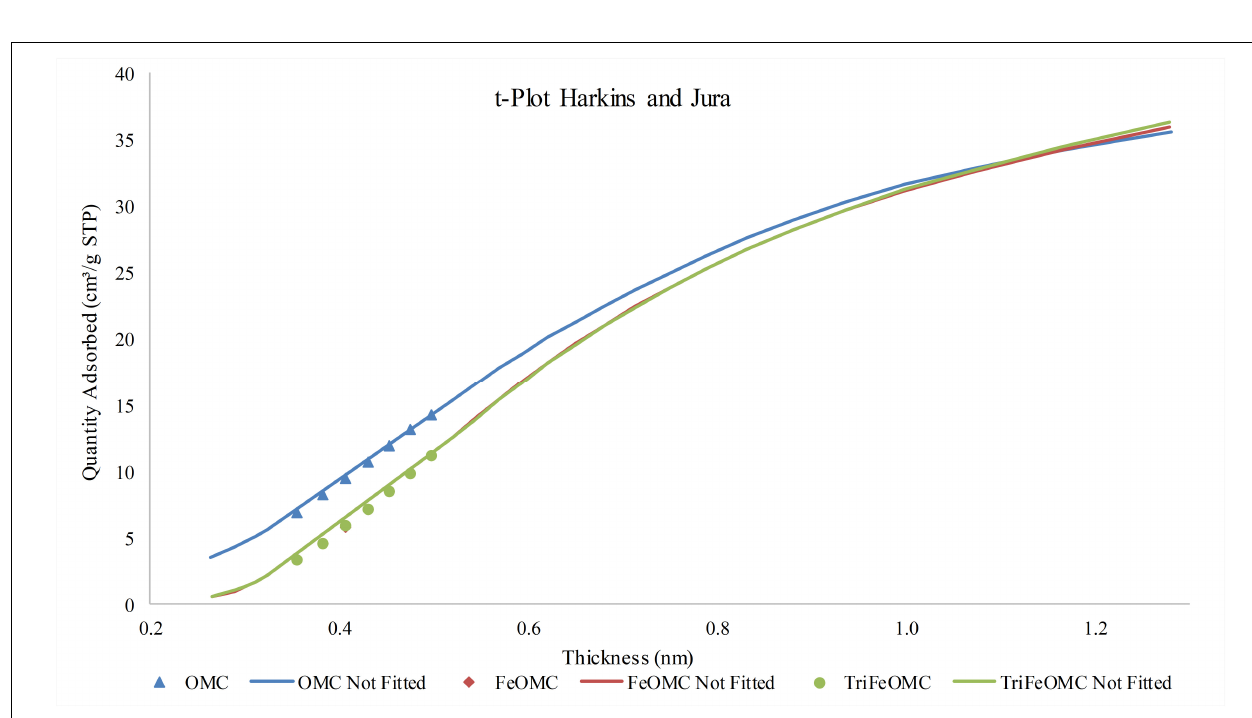
FIGURE 5 | The t-plot (Harkins and Jura) between nitrogen adsorption quantity vs thickness of OMC, FeOMC, and TriFeOMC.